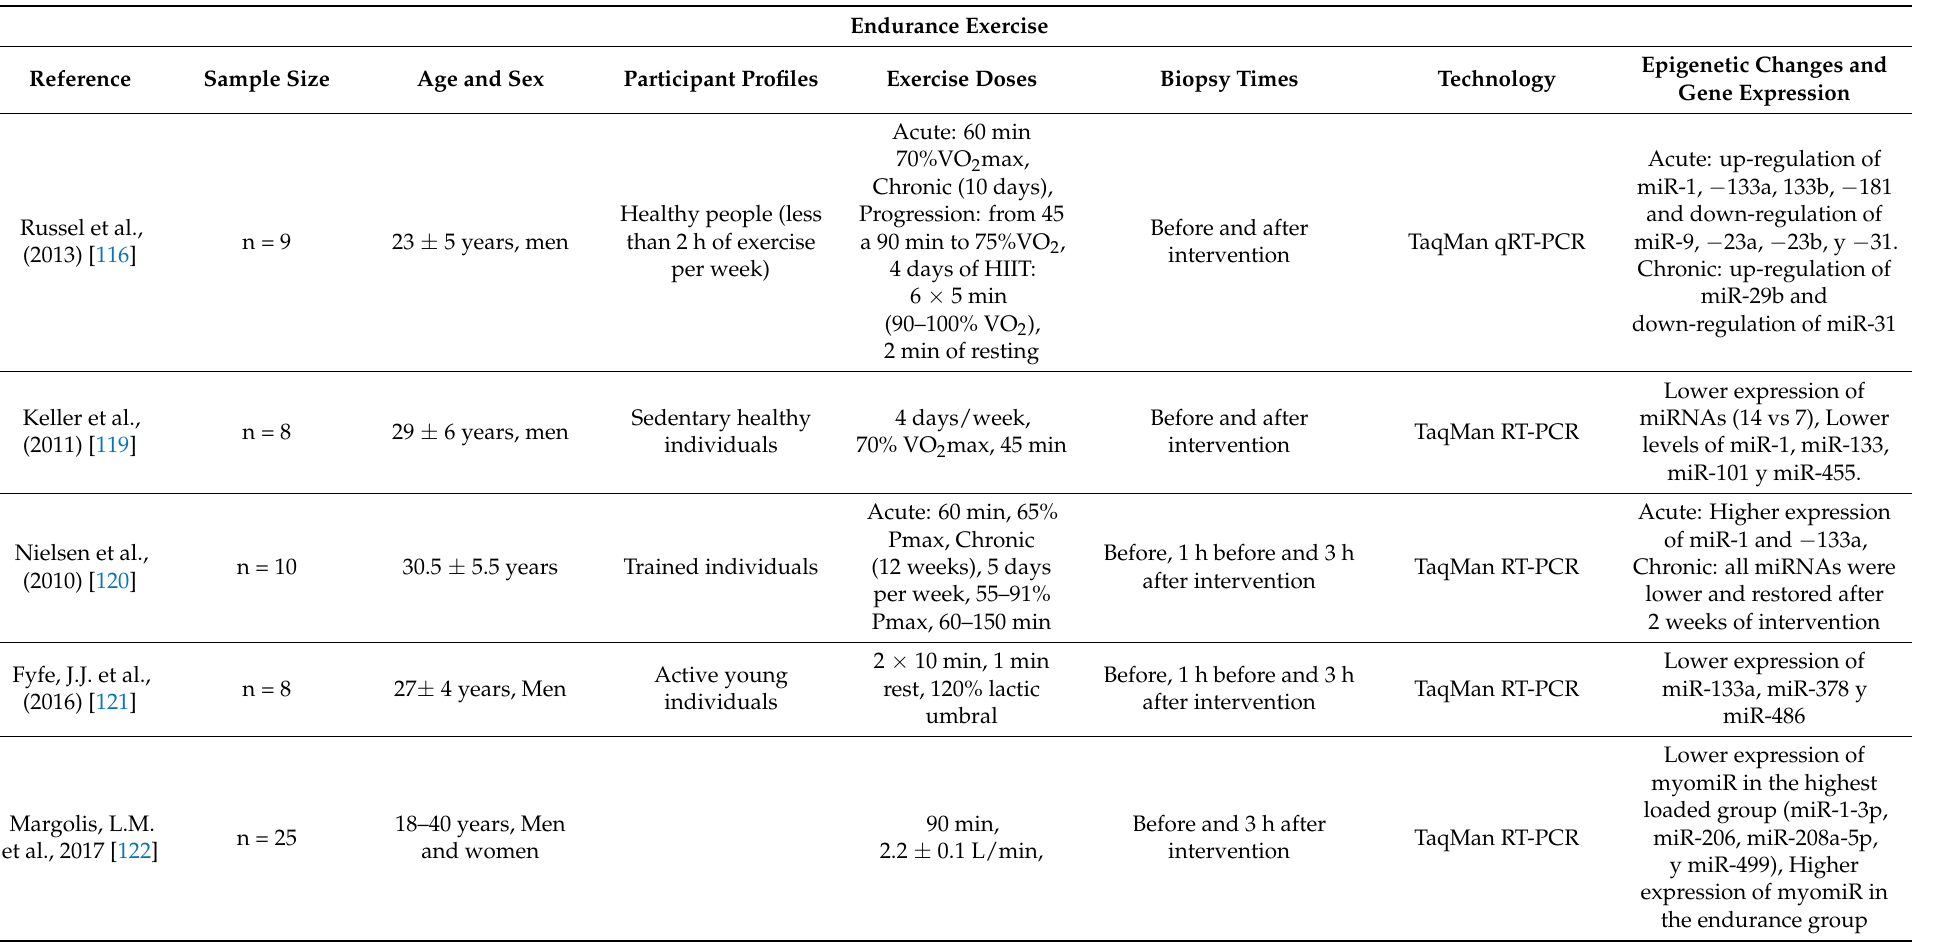
Table 3. Effects of endurance and resistance training on mi-RNAs generation in skeletal